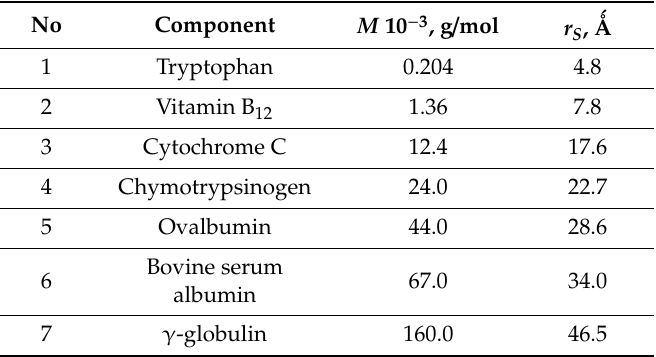
Table 1. Model mixture of proteins for membrane calibration; M is the molecular weight of a protein, and r S is the Stokes radius of a protein molecule.